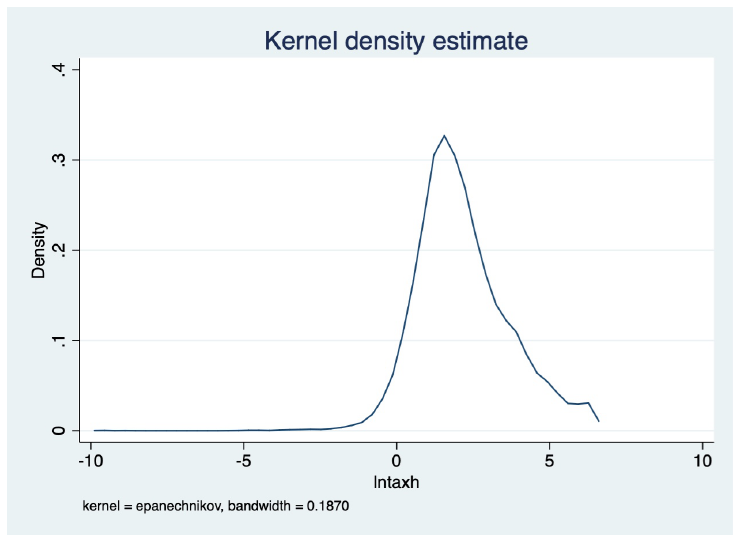
Figure A2. Distribution of the Log of Tax